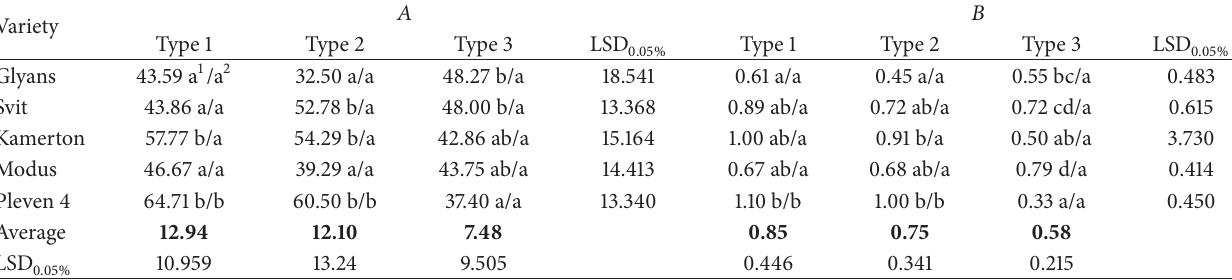
Table 4: Laying activity of Bruchus pisorum in pea